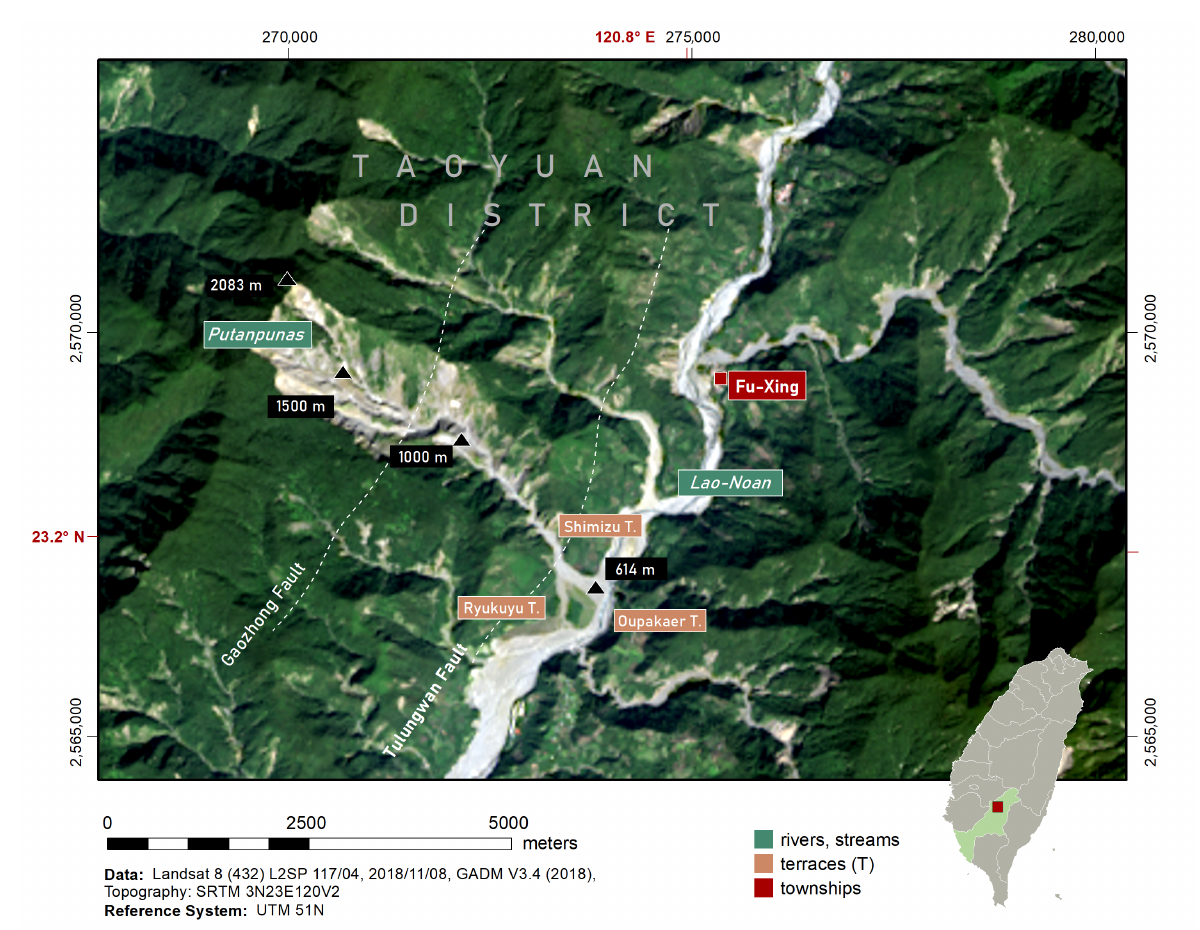
Figure 1. Location of the larger Putanpunas stream area in the northern part of Kaohsiung City county in southern